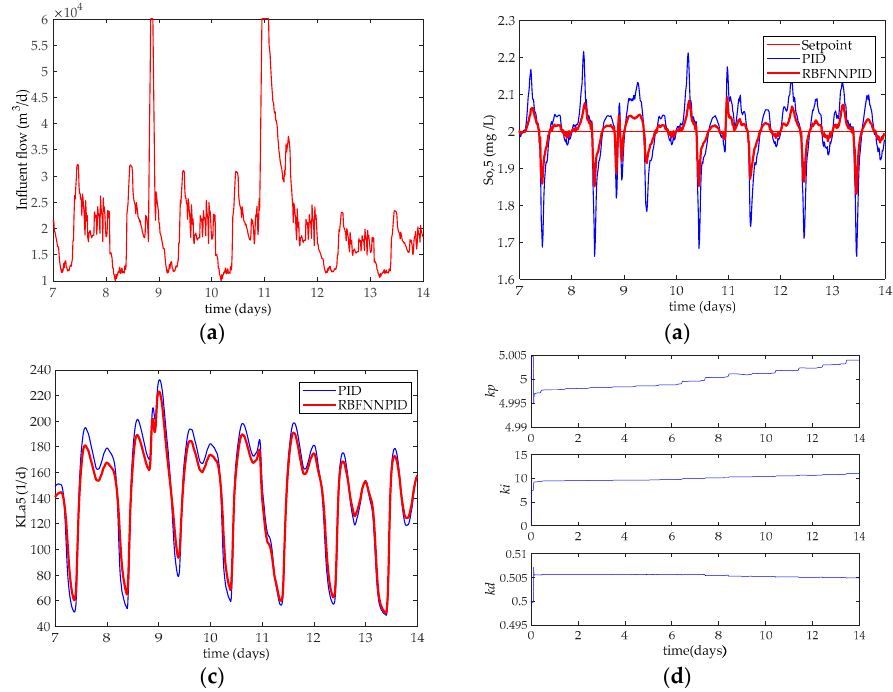
Figure 9. Comparison results of the anti-disturbance performance (storm weather): ( a ) Influent flow rate (days 7 to 14); ( b ) DO concentration in the fifth tank; ( c ) Dynamic changes of the manipulated variable K L a 5 ; ( d ) Dynamic adaptive adjustments of the three parameters kp , ki , kd of RBFNNPID algorithm.